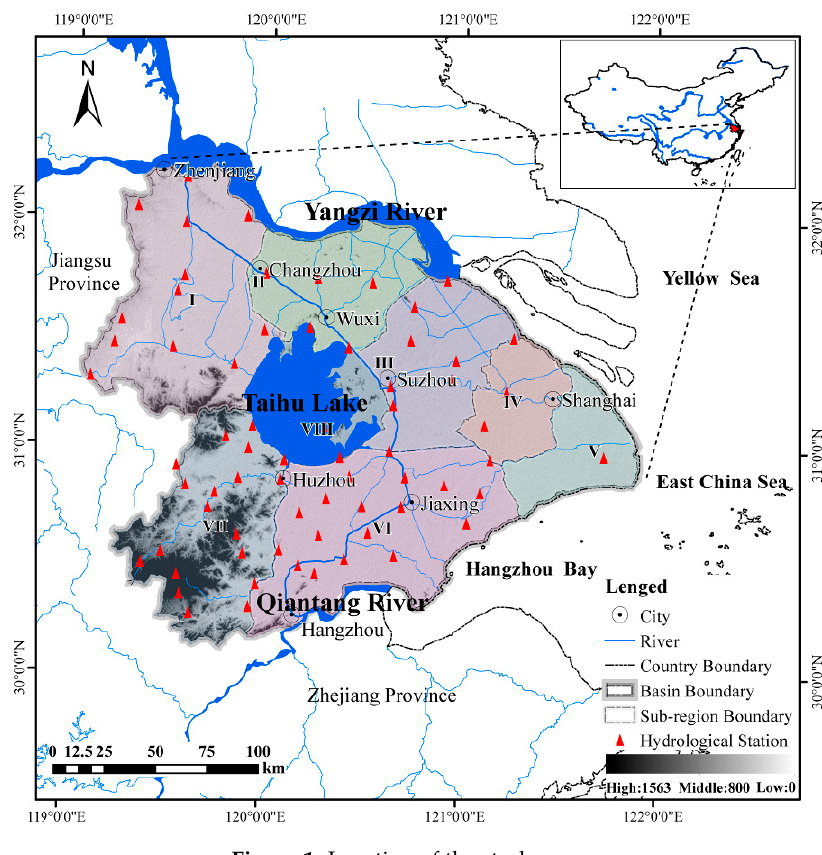
Figure 1. Location of the study areas. Table 1. Information on eight hydrological